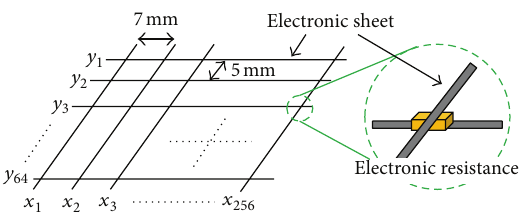
Figure 2: Internal constitution of the load distribution